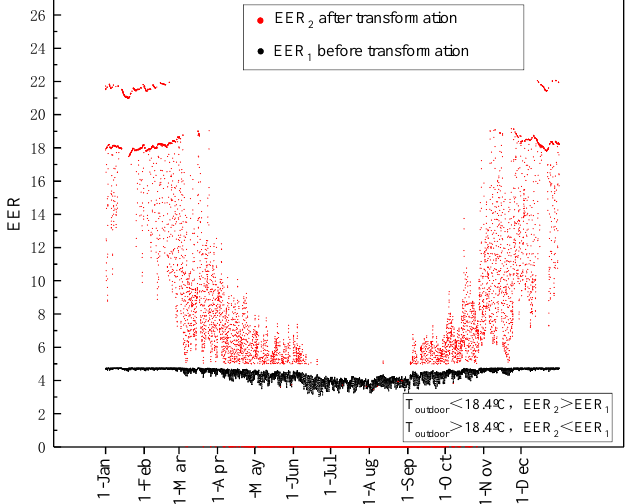
Figure 26. Annual hourly energy efficiency ratio (EER) of DCs before and after the transformation.